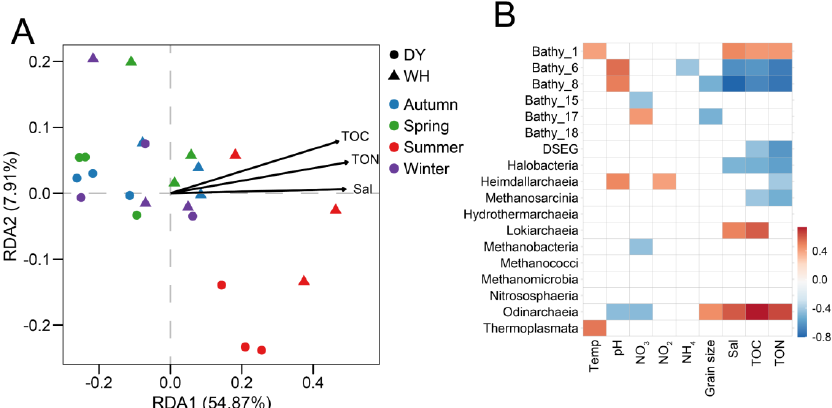
Figure 7. The redundancy analysis (RDA) plot showing relationships between archaeal community and environmental variables ( A ). A heatmap showing correlation coefficients ( ρ ) between relative abundance of major taxa of archaea at class level and environment factors ( B ). Only significant correlations ( p < 0.05) are shown in both analyses. The values of correlation coefficients are indicated according to the scale bar. Abbreviations: TOC, total organic carbon; TON, total organic nitrogen; Sal, salinity; Temp, temperature.